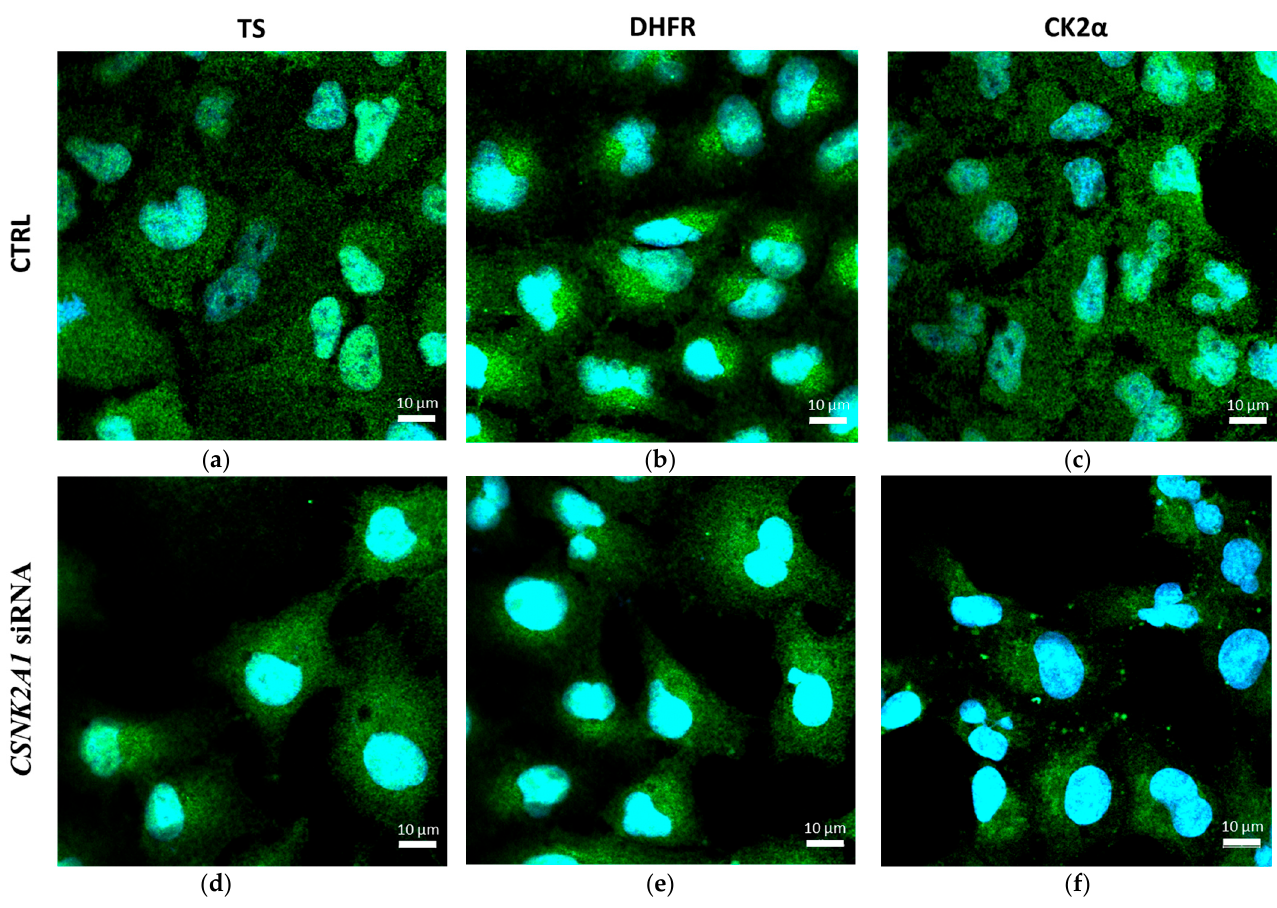
Figure 4. The effect of silencing of CSNK2A1 on localisation of DHFR ( e ) and TS ( d ) in A-549 cells. Detection of TS, DHFR and CK2 α in control cells are shown in ( a ), ( b ), ( c ), respectively. The cells were treated with 100 nM CSNK2A1 siRNA for 72 h ( d – f ), fixed, and after blocking, probed with the primary anti-DHFR or anti-TS antibodies. Subsequently, the cells were treated with Alexa Fluor 488-conjugated anti-mouse secondary antibody (green fluorescence) and Hoechst 33, 342 (nuclei, blue fluorescence).